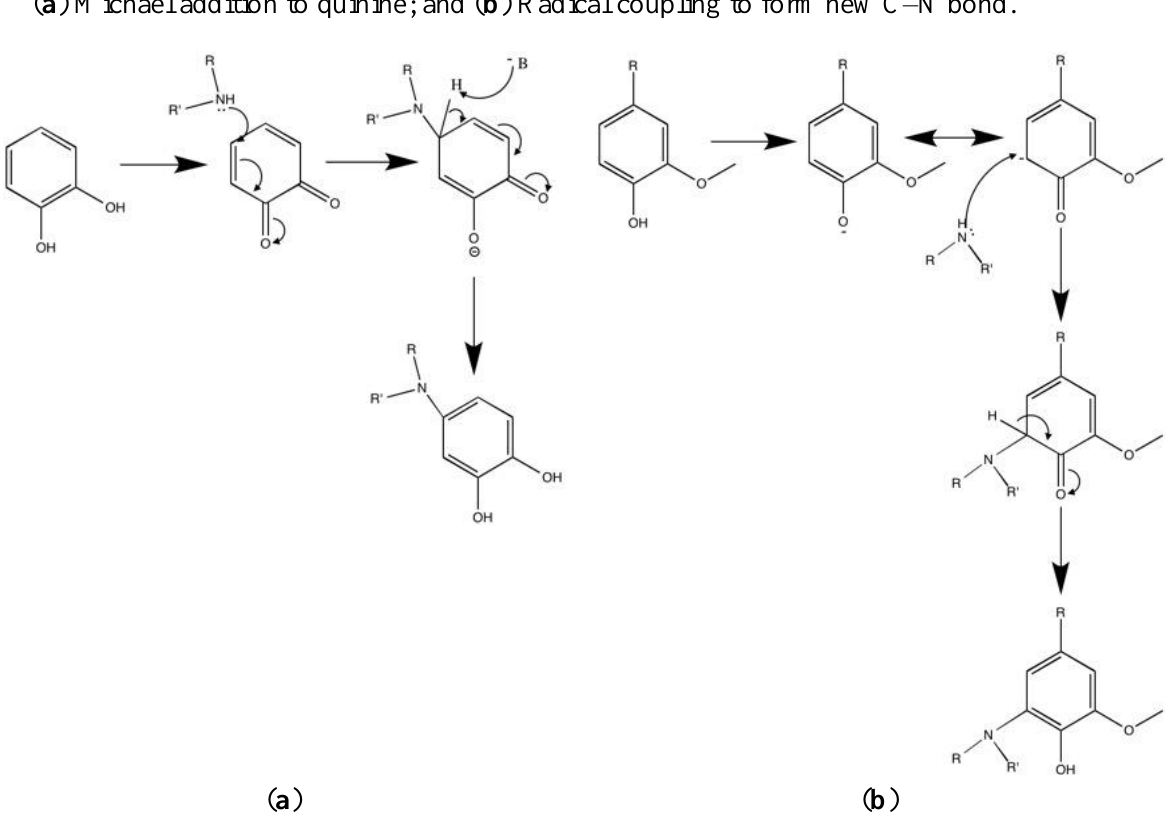
Figure 2. Reaction mechanism for the coupling of amines to phenolic radicals